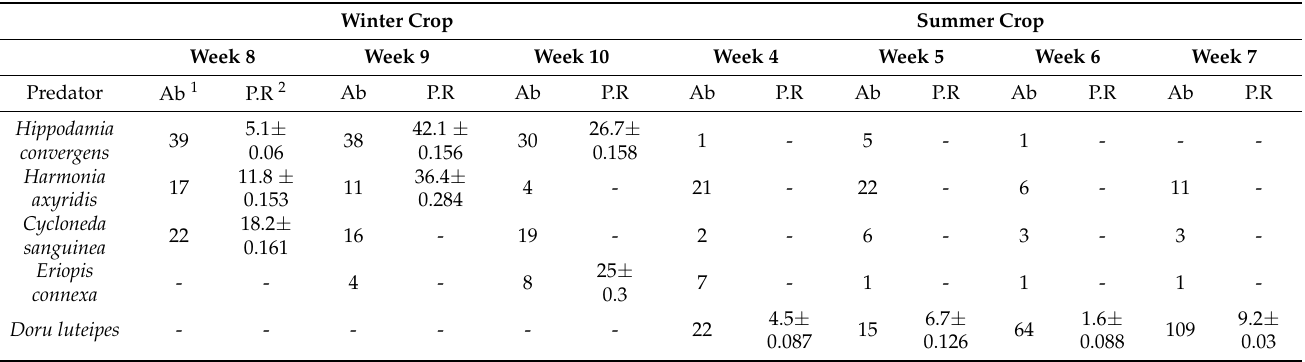
Table 1. Weekly abundance and predation rates for each predator that showed positive results for predation on Spodoptera frugiperda in winter and summer